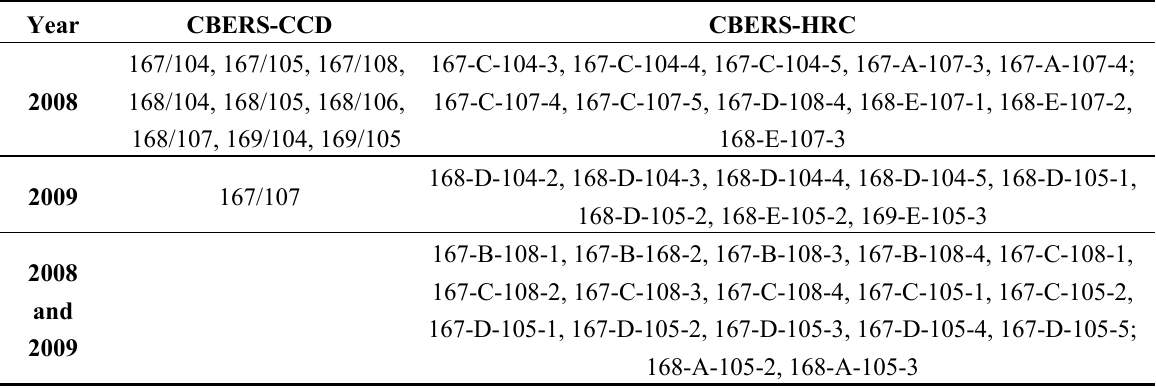
Table 2. CBERS-CCD and CBERS-HRC images of the study